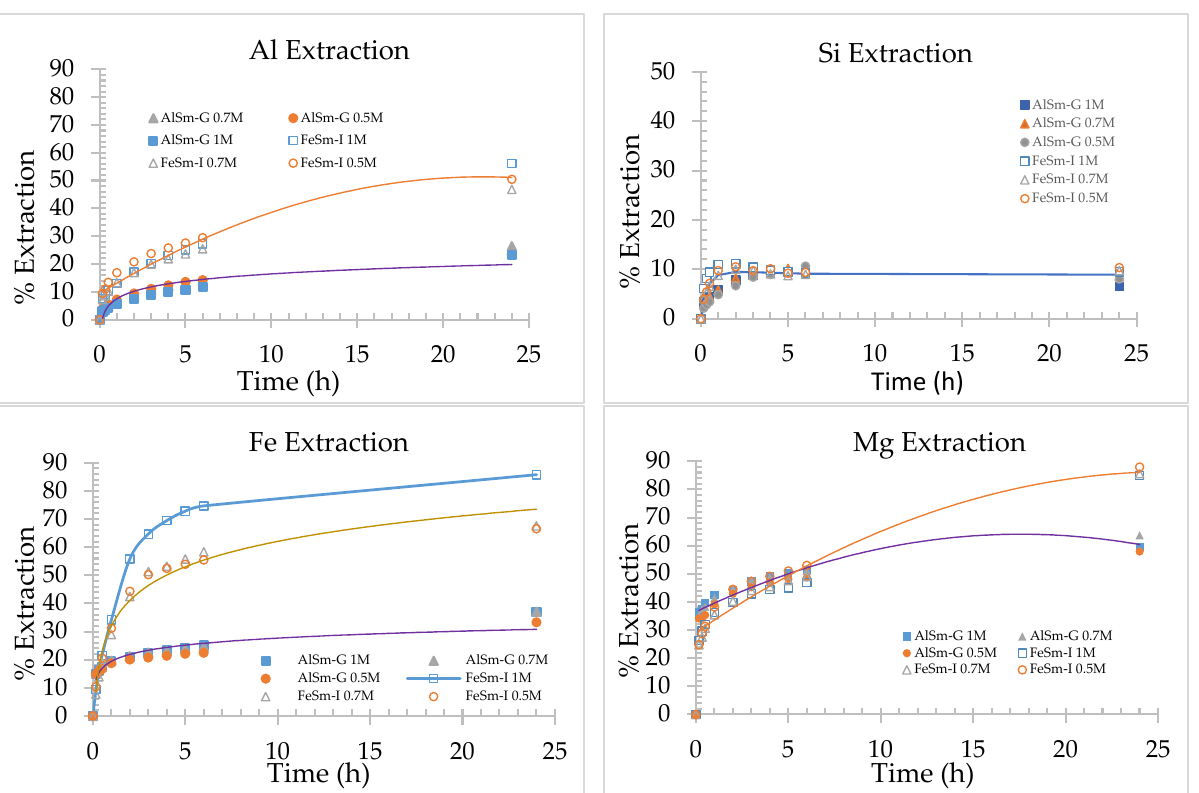
Figure 2. ( a ) FTIR spectra of AlSm-G smectite (raw and activated with 0.5, 0.7, and 1 M oxalic acid); ( b ) FTIR spectra (Section 1000–800 cm − 1 ) of raw and treated AlSm-G smectites.